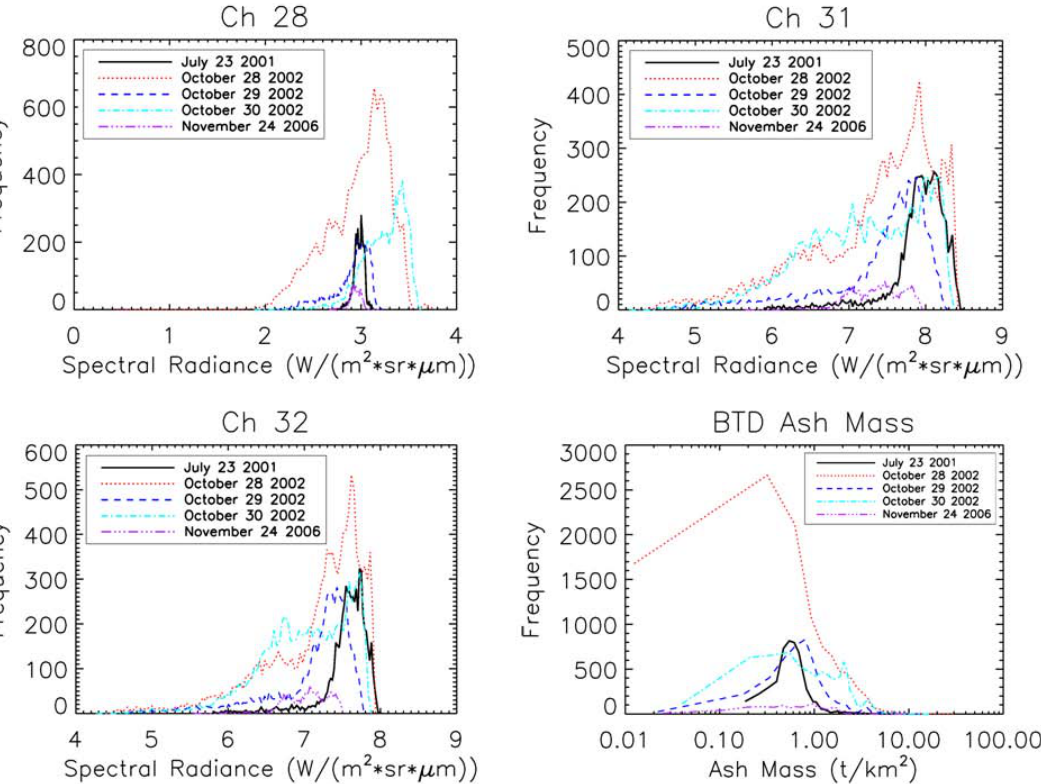
Fig. 4. The histograms computed for the three considered MODIS channels and for the BTD ash mass esteemed values, for the five considered acquisition date. Top Plates, from left to right: MODIS CH28 and CH31. Bottom Plates, from left to right: MODIS CH32 and BTD Total mass esteemed